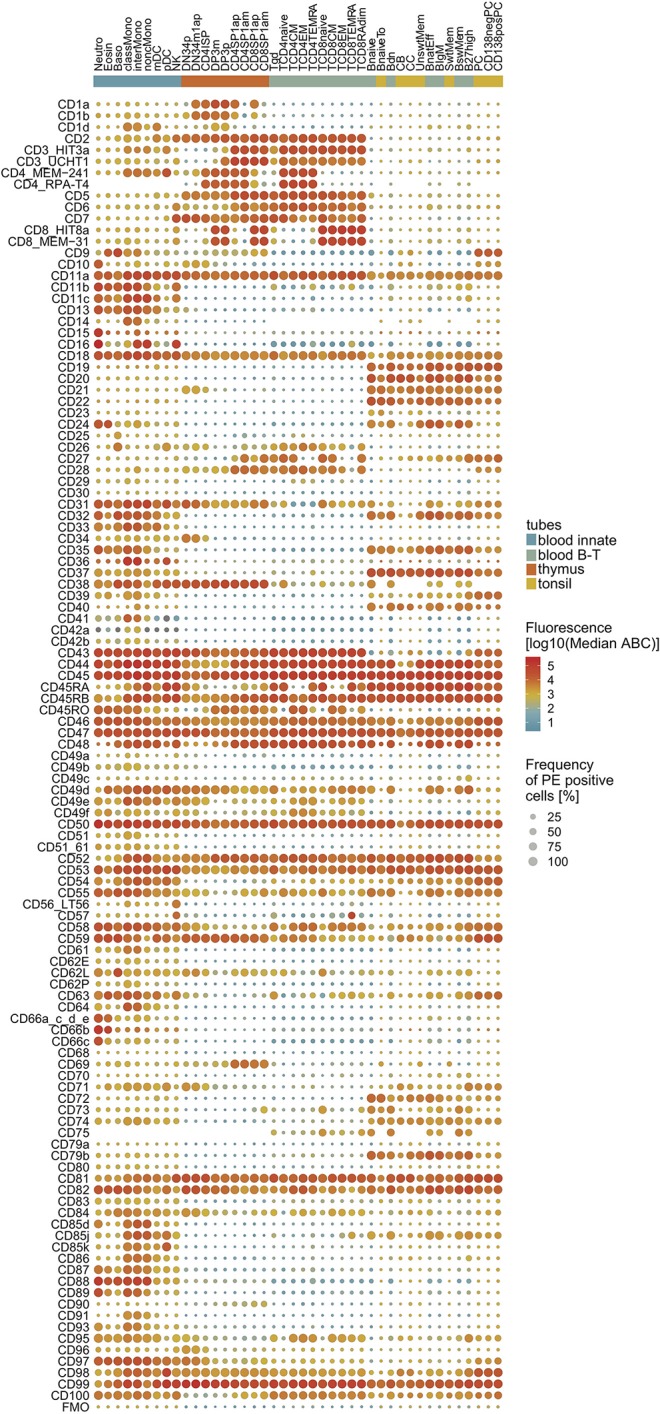
Expression map of CD1–CD100 on all 42 non-overlapping cell subsets. CD markers are numerically ordered vertically with the FMO on the bottom row. The cell subsets are grouped (innate cells; thymocytes; T-cells; B cells) and sorted within lineage on their maturity. The median expression level is visualized by color, and the median percentage of positive cells is visualized by the size of the dot. For cell type abbreviations, see Supplementary Table 3.